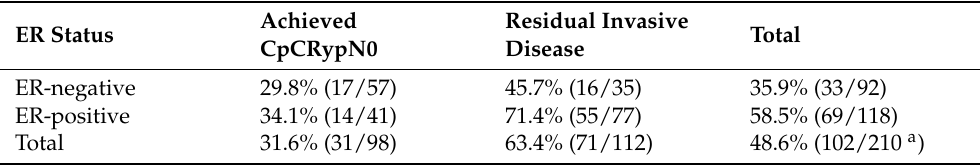
Table 2. Proportion of patients who received adjuvant anthracycline chemotherapy.